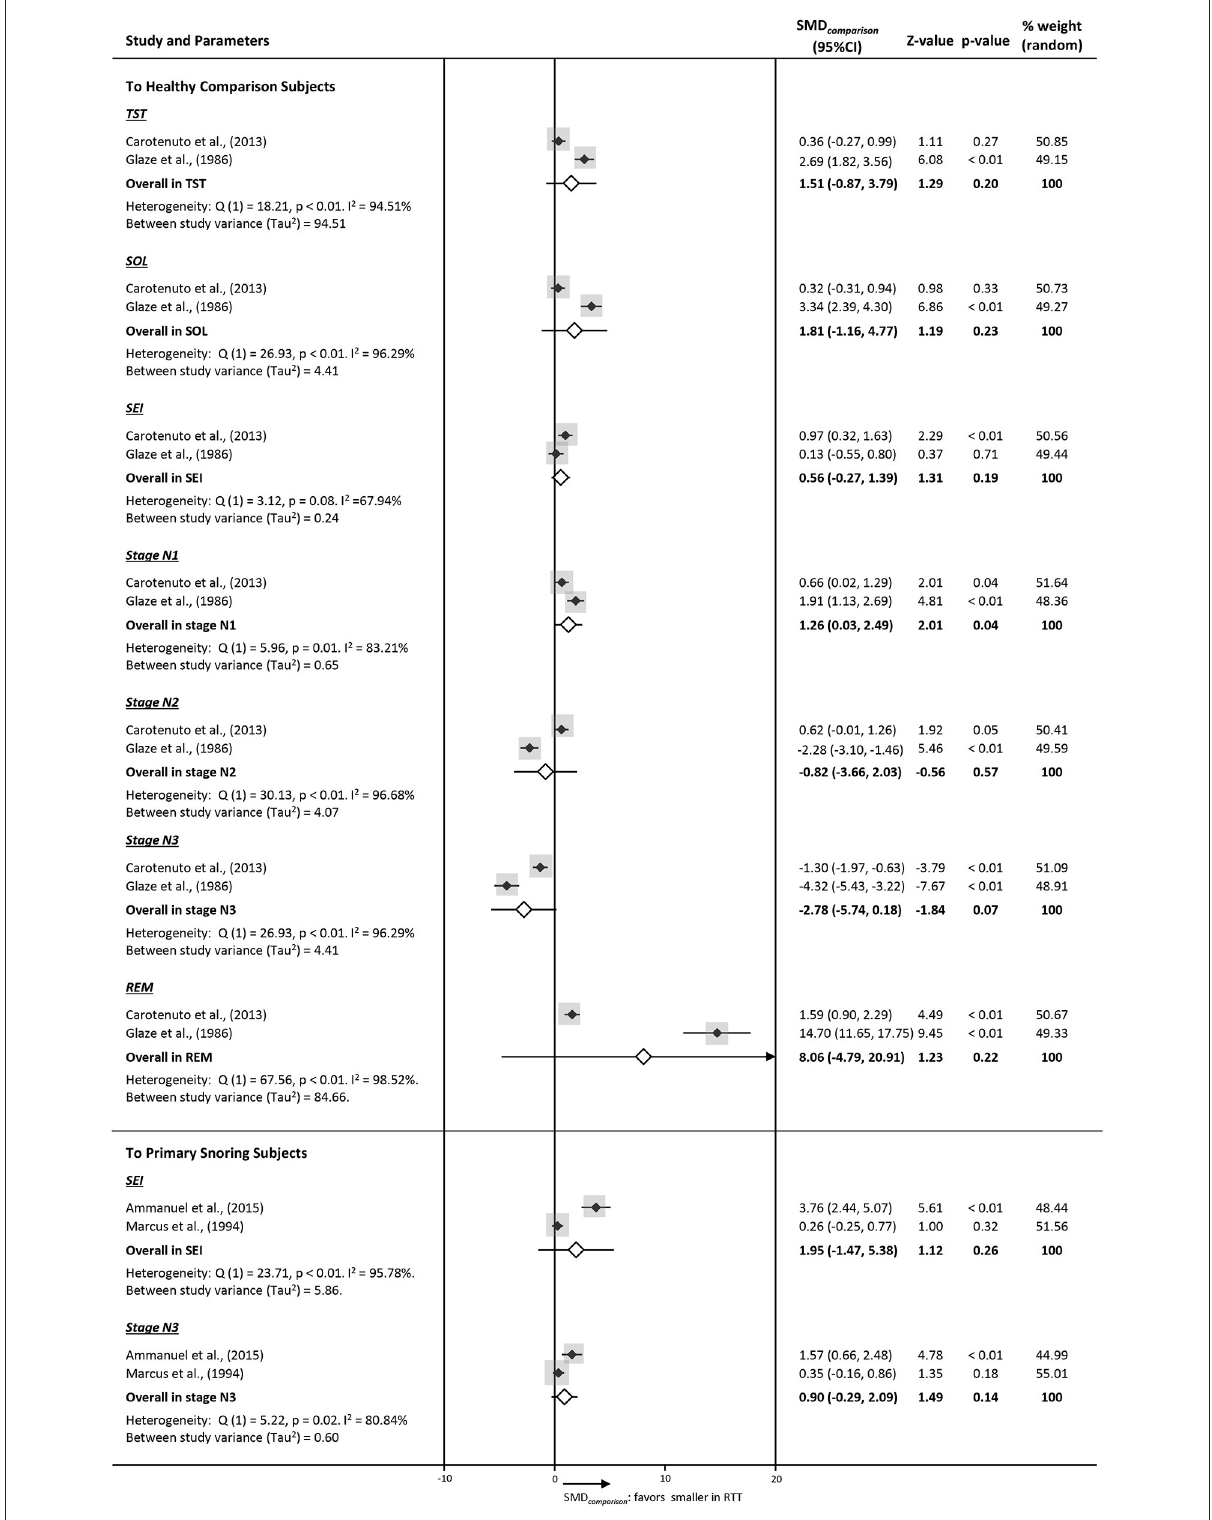
FIGURE3 Forest plots of PSG parameters on sleep macrostructure of studies comparing RTT with a comparison group (SMD comparison ). Diamonds indicate standard mean difference (SMD comparison ) with a confidence interval of 95% (error bars 95% CI). The size of the gray square indicates the relative weight of the study on the combined